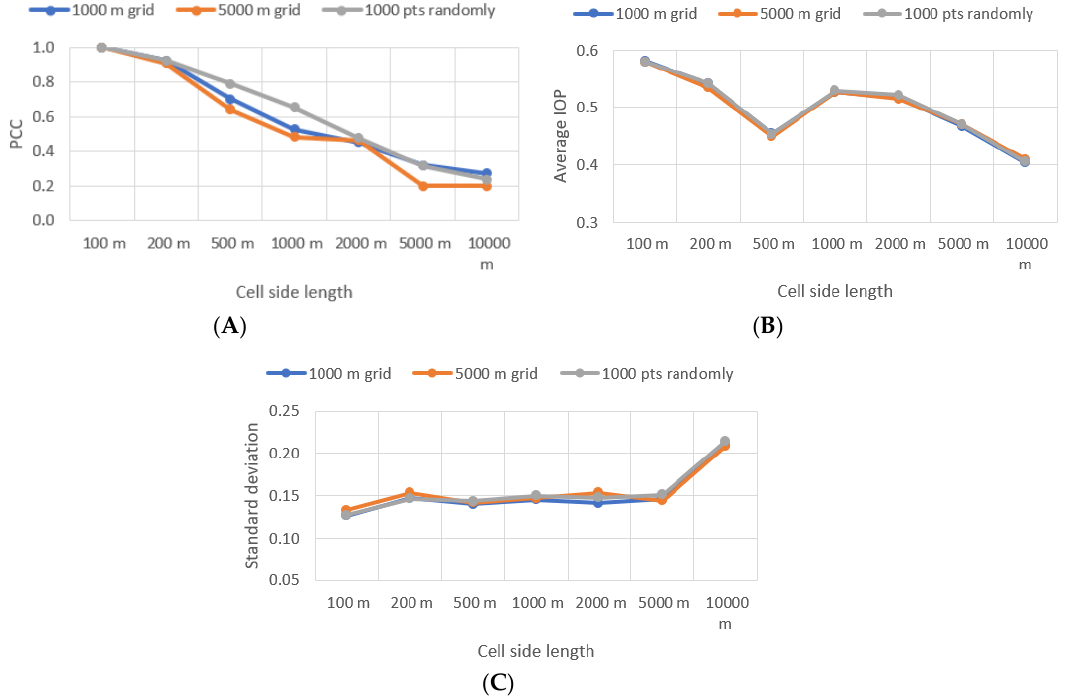
Figure 17. Correlation between the values of statistical parameters and cell size for test area. ( A ) Correlation between PCC and cell size (for 100 m fields) for test area; ( B ) Correlation between average IOP and cell size for test area; ( C ) Correlation between standard deviation and cell size for test area.